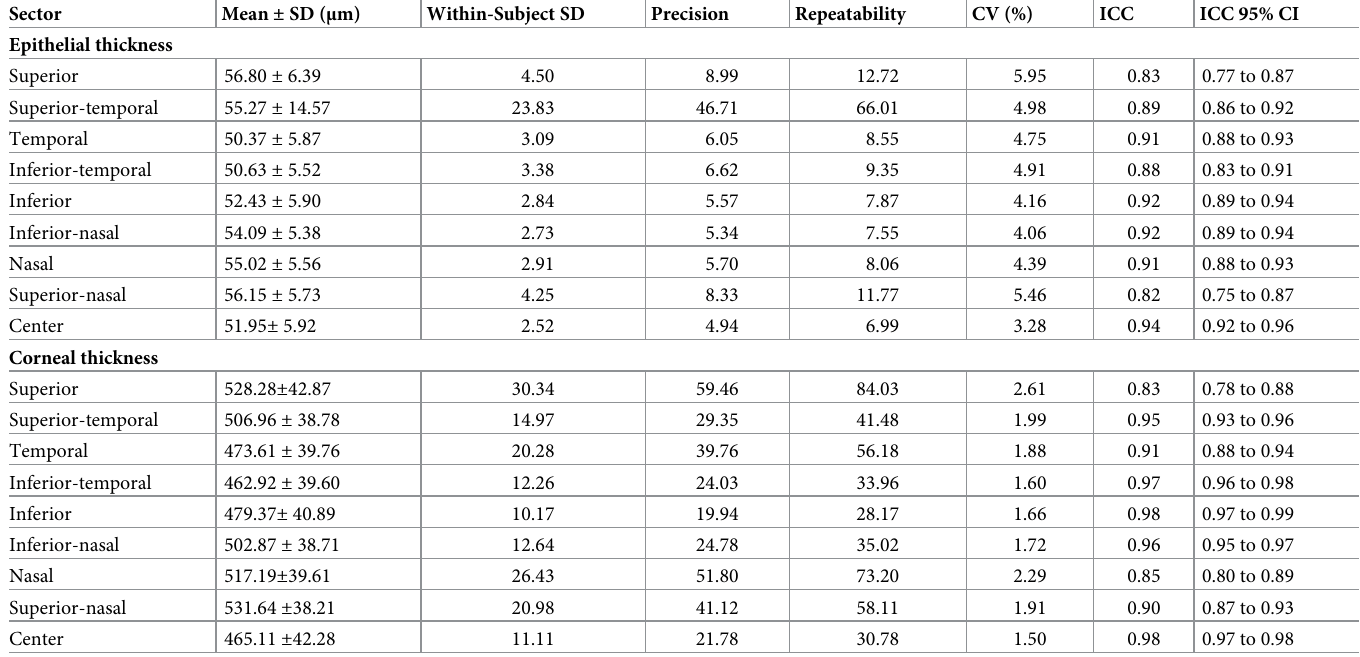
Table 3. Measurements in Group B: Eyes with a history of prior